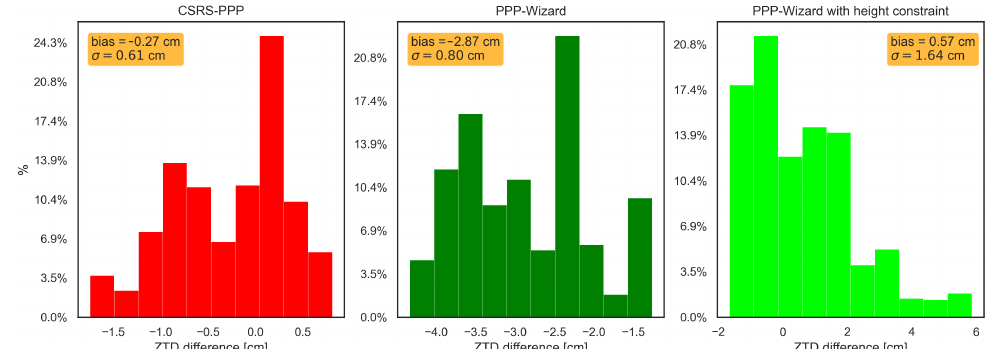
Figure 11. Histograms of the ZTD differences between estimated GNSS-ZTD (CSRS-PPP (red), PPP-Wizard (green), and PPPW-HC (lime)) and ERA-ZTD for CS2. Additionally bias and standard deviations are indicated for each GNSS-ZTD solution.